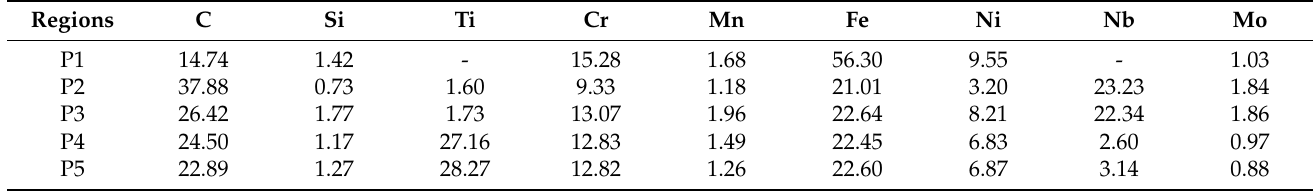
Figure 5 indicates the microhardness distribution of the 316L coating and the com ‐ posite coating along the building direction. The results show that the microhardness of top of the coating. It gradually decreases along the direction of coating growth and even ‐ tually tends to a stable value. The average microhardness of the fabricated 316 coatings is 181.14 ± 2.77 HV, which is consistent with existing research results [29]. When 10 wt% TiC and 10 wt% NbC ceramic particles are added, the microhardness of the composite coating is 232.12 ± 2.91 HV, which is 1.28 times that of the 316L coating. The increase in hardness of the composite coating is the result of grain refining and solution strengthening. As shown in Figure 5, fine hard particles are distributed near indentation 4. These high hard ‐ ness TiC (32 GPa) and NbC (24.1 GPa) act as a frame, weakening the grain dislocation and inhibiting the deformation of the composite coating. In addition, the microstructure anal ‐ ysis shows that TiC and NbC can refine the grains of the composite coating, resulting in the improvement of plastic deformation resistance. Interestingly, the microhardness of the 316L and composite coatings decreases with the deposition height. As the number of de ‐ posited layers increases, heat accumulation results in a gradual increase in the maximum temperature of the melt pool. As a result, the previous deposition layer was subjected to a tempering heat treatment, which led to a gradual decrease in microhardness [30]. How ‐ ever, the high density of NbC particles (7.56 g/cm 3 ) tends to be more distributed at the bottom of the single track under the effect of strong Marangoni convection, resulting in the high microhardness at the bottom of the coating [16]. The material on top of the coating would be removed during subsequent machining, so the characteristics of the microhard ‐ ness distribution are beneficial to improve the practical application of the coating. There ‐ fore, it should be noted that the maximum microhardness in the heat ‐ affected zone is 315 HV. According to the microstructure near Indentation 2, the acicular martensite is gener ‐ ated due to rapid cooling, which effectively improves the microhardness. With the in ‐ crease in the test depth, the cooling rate of the substrate decreases gradually. Therefore, the acicular martensite was gradually transformed into lamellar martensite. The